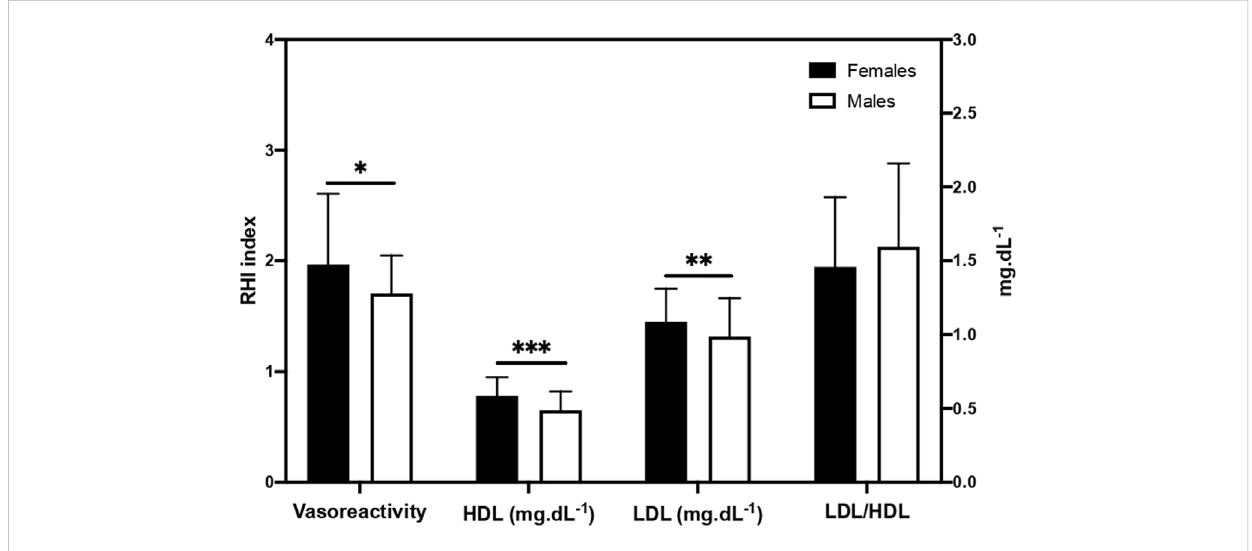
FIGURE 2 Reactive hyperemia index and lipoproteins. Data are mean ± SD. HDL, high density lipoprotein; LDL, low-density lipoprotein; RHI, reactive hyperemia index. LDL/HDL ratio values refer to the right axis. Signi fi cantly different between males and females: * p < 0.05, ** p < 0.01, *** p < 0.001.